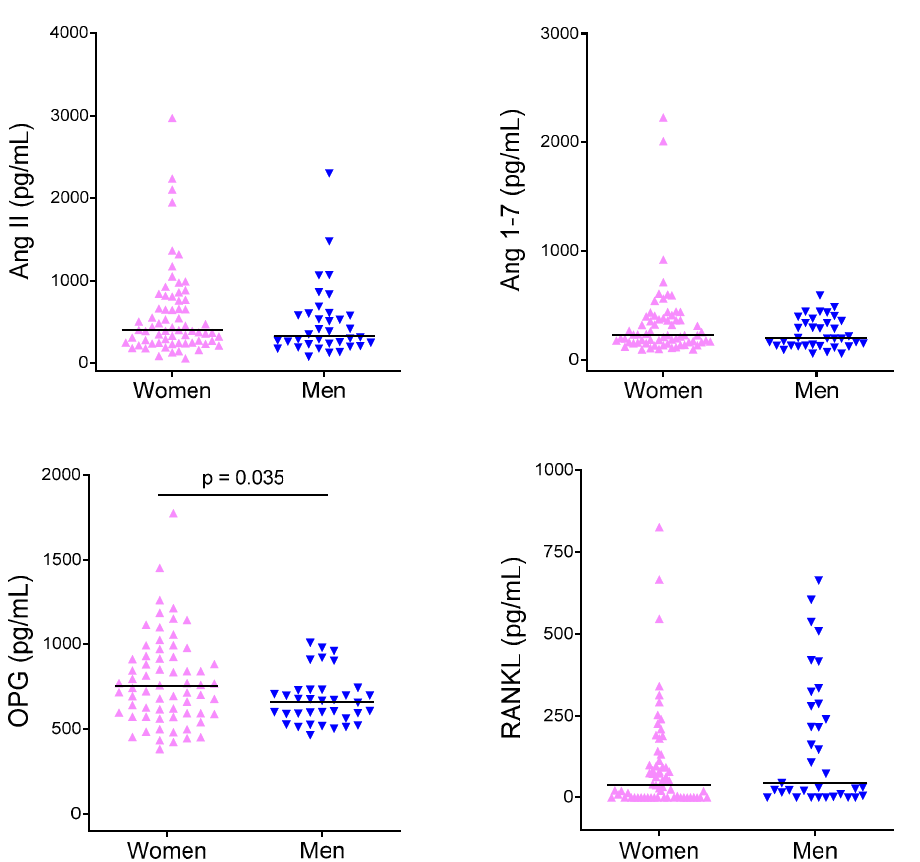
Figure 1. Proatherogenic cytokine levels in women and men. Circulating levels of IL-1 β , IL-6, TNF- α , as well as angiotensin-converting enzyme-2 (ACE2), Ang II, Ang 1-7, osteoprotegerin (OPG), and receptor activator of nuclear factor κ B ligand (RANKL). Bars are median values.